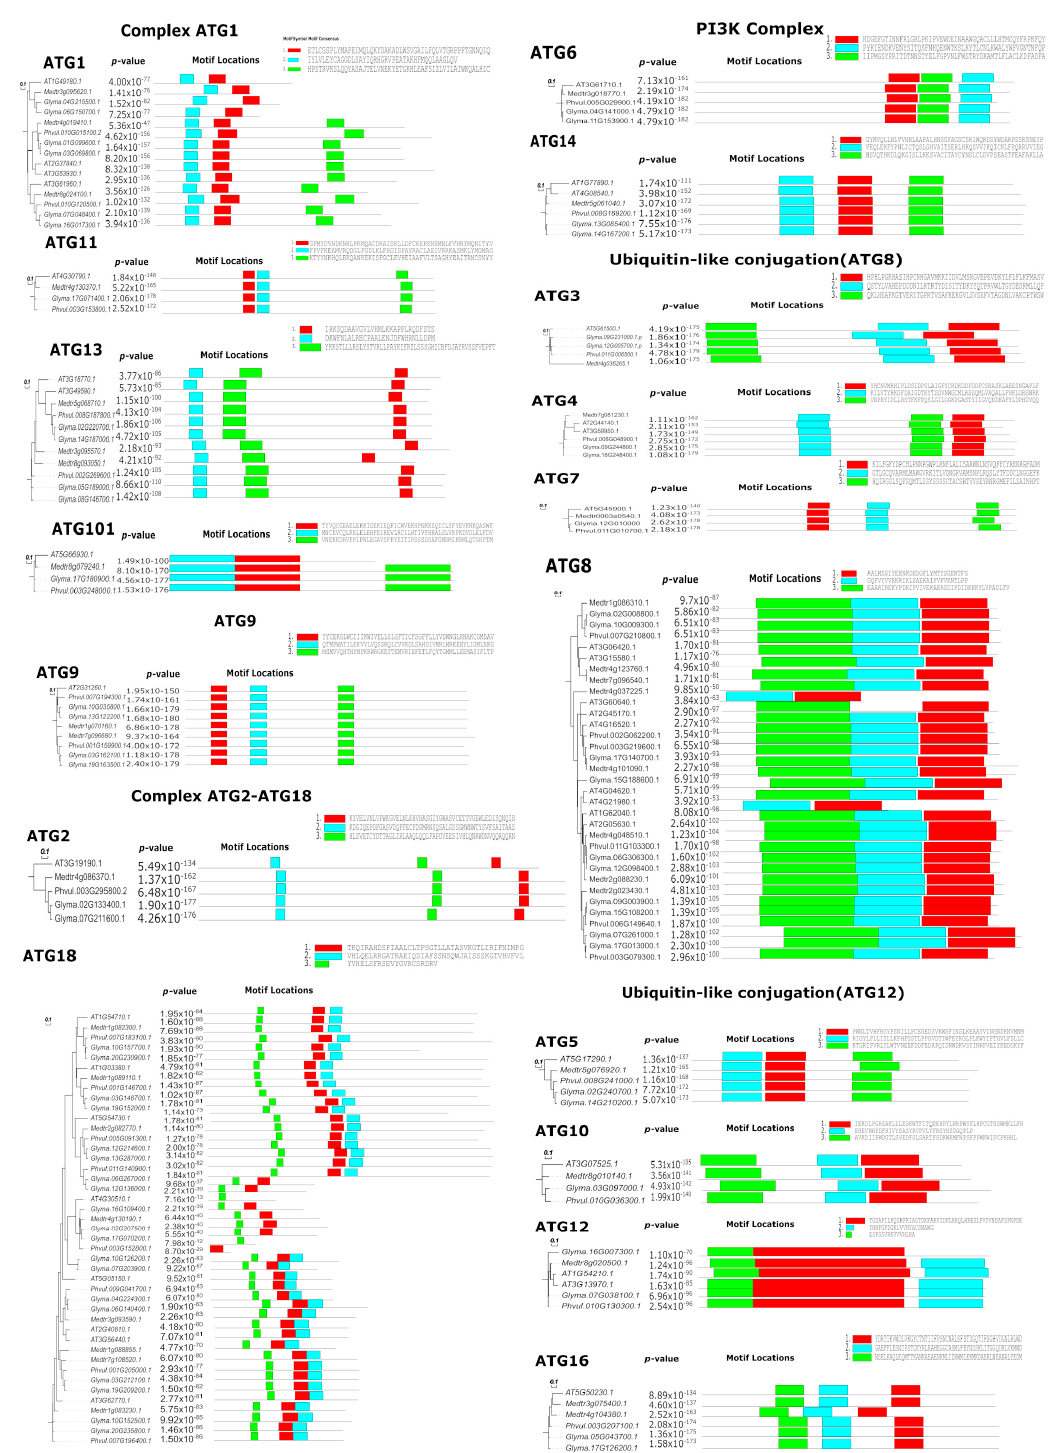
Figure 1. Phylogenetic analysis and protein motifs of 17 ATG families in A. thaliana , P. vulgaris , M. truncatula and G. max . The phylogenetic tree was constructed with the neighbor-joining method with 1000 repeated bootstrap tests, p-distance and pairwise deletion in MEGA X software and visualized using EvolView. MEME was used to identify motifs of the ATG homologs in A. thaliana , P. vulgaris , M. truncatula and G. max. The chromosome localization of ATGs in the A. thaliana and legume genomes was mapped using Circos (Figure 2). The distribution of ATG homologs among the chromo ‐